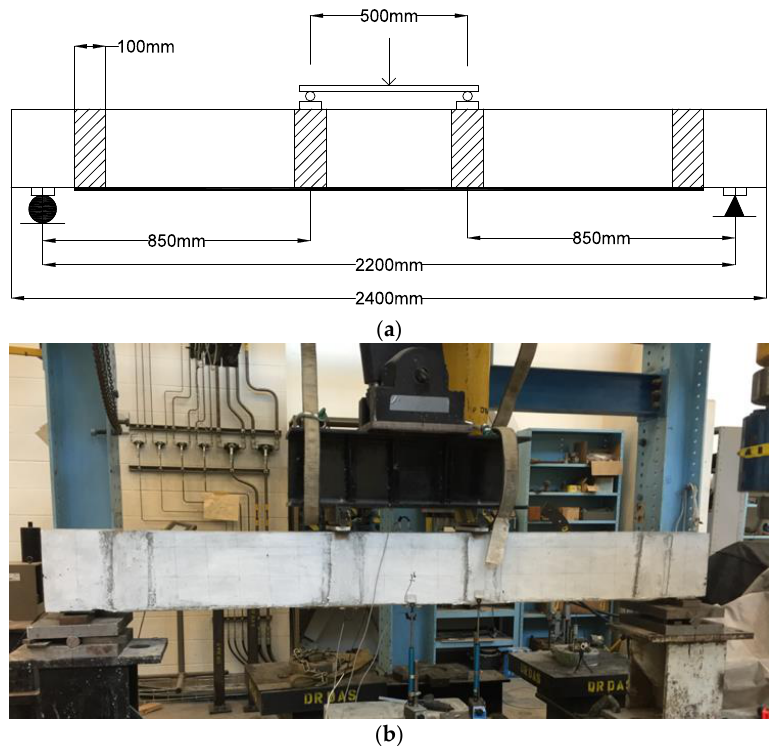
Figure 8. Test setup: ( a ) test set-up details; ( b ) photo of the test set-up.